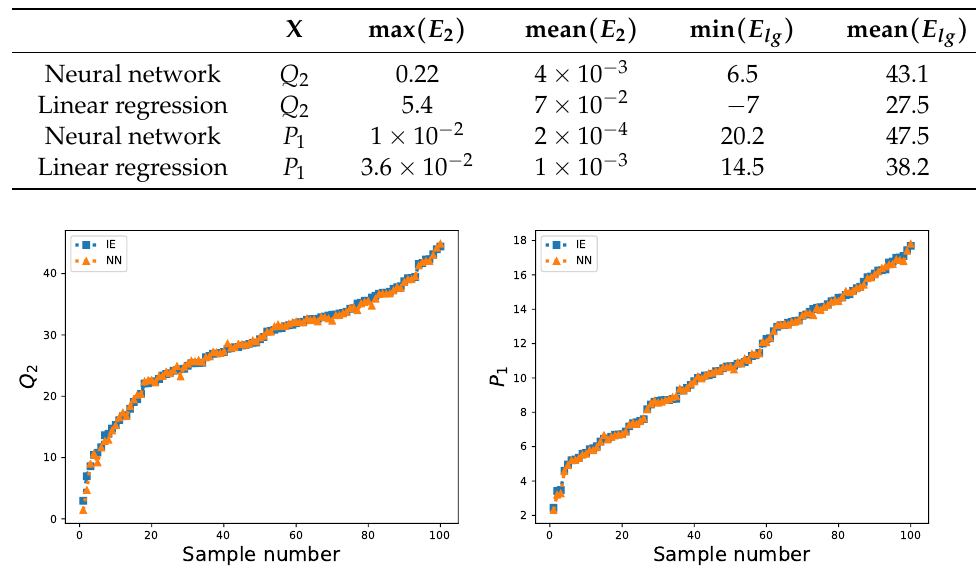
Figure 6. Output values Q 2 , P 1 on validation dataset. Notations: IE—integral equation model, NN—neural network model.